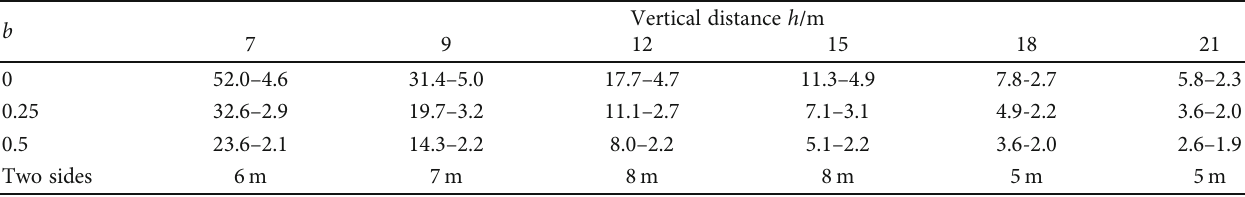
Table 1: Pressure relief coe ffi cients (%) at the center line of the roadway and coal seams at two sides.